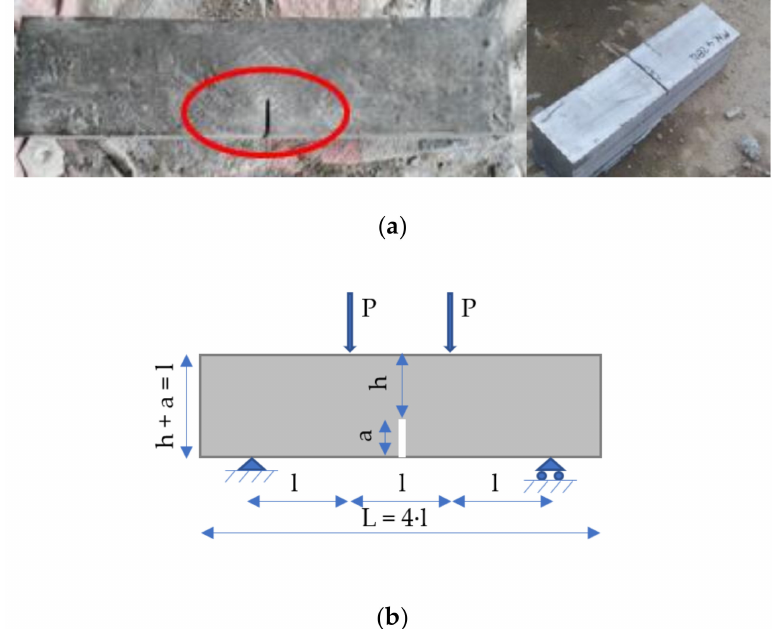
Figure 2. Bending test on high-performance fiber reinforced concrete (HPFRC) with different polymer fiber volume fractions: ( a ) Beam with notch and ( b ) four-points bending test